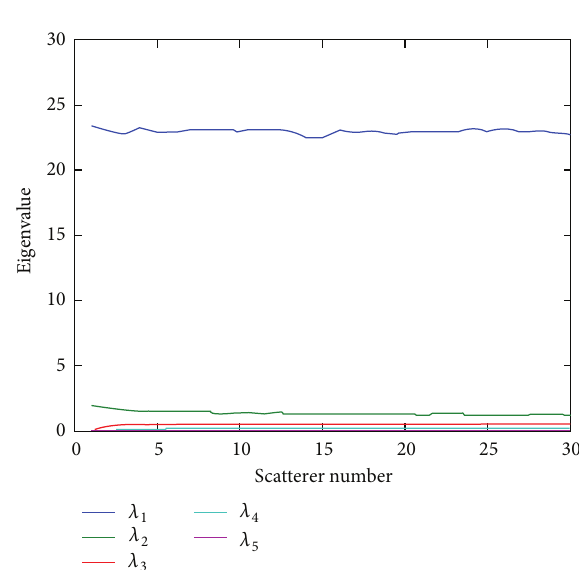
F 6: Eigenvalues comparison in